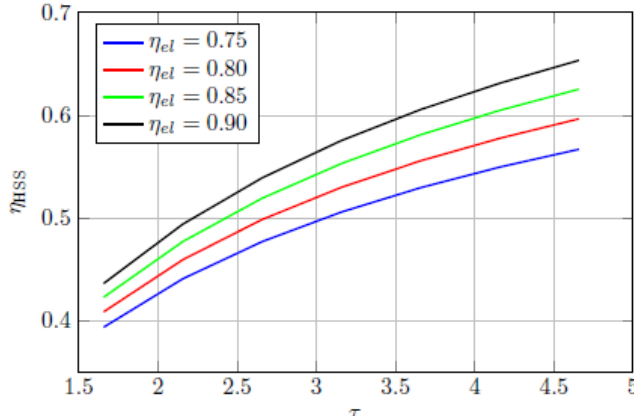
Figure 7. Efficiency of the multistage HSS system as a function of τ with a single stage of expansion for different stages of compression, n c , from 1 to 4 ( a ) and with two stages of compression for different stages of expansion, n t , from 1 to 4 ( b ). The plot refers to a system, β c = 20, β e = 0.9 * β c , η el = 0.80, η t = 0.9, η c = 0.9, and η cc = 0.98.